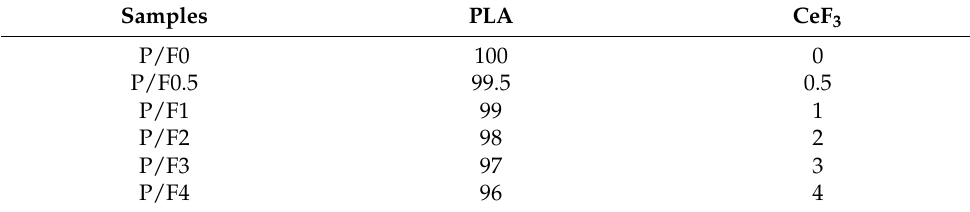
Table 1. Formulation of P/F films by mass fraction